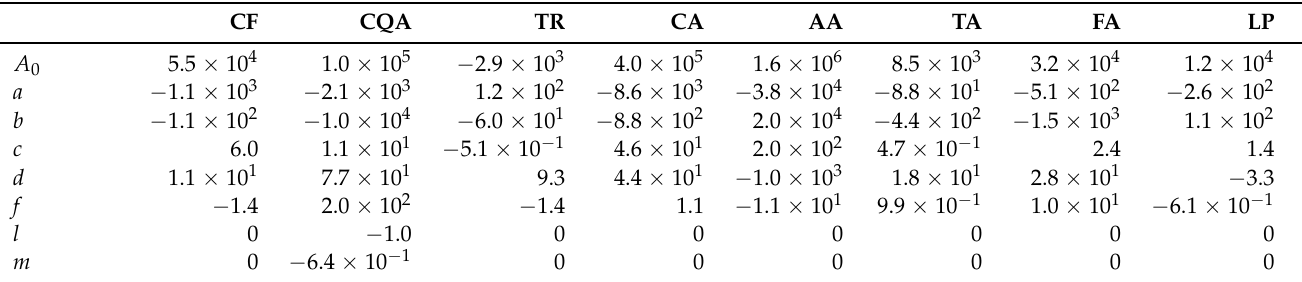
Table A3. Coefficients of the dissolution rate α r , v granulometry r = F and Arabica variety v =